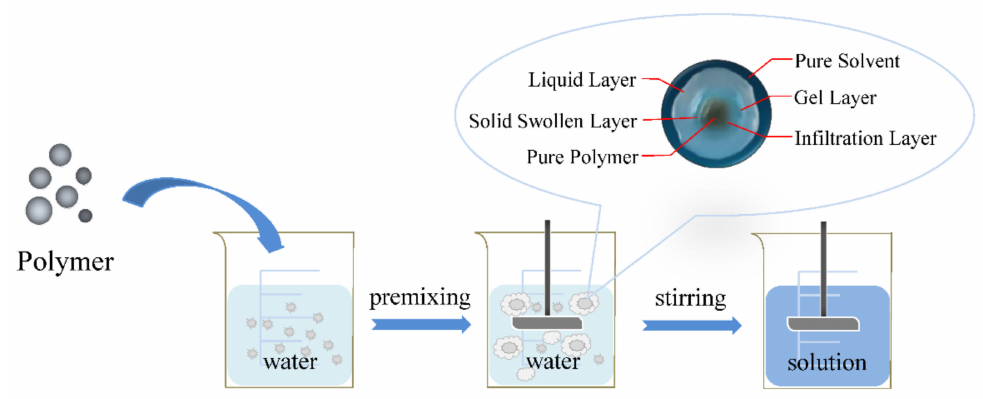
Figure 2. Polymer micro-solution